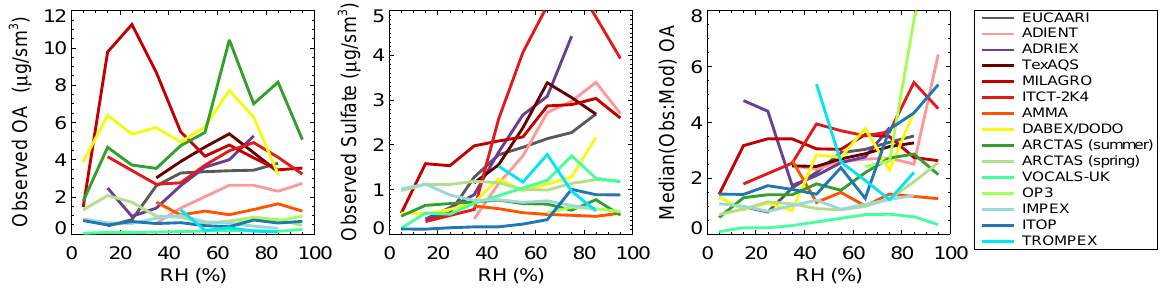
Fig. 10. Mean observed organic aerosol (left), sulfate (middle) concentrations as a function of relative humidity for 16 aircraft field cam- paigns. Final panel (right) shows median observed to simulated ratio of OA concentrations as a function of measured relative humidity for each campaign. Data is averaged in 10% RH bins. Data is only shown when the number of points per bin exceeds 2% of the total observations (to eliminate